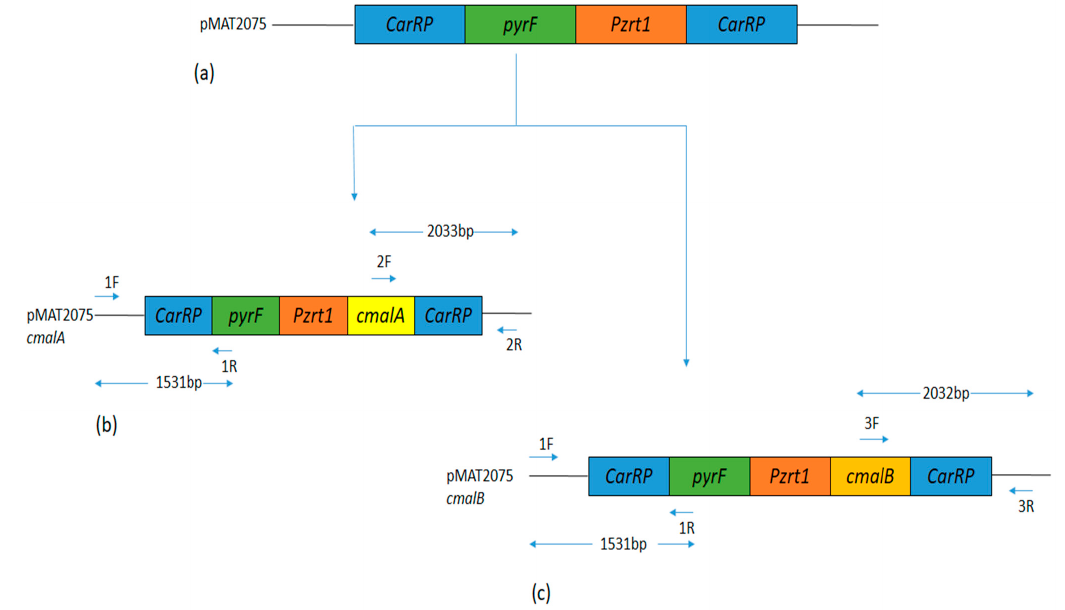
Figure 1. Overexpression of cmalA and cmalB genes. ( a ) Plasmid structure of plasmid pMAT2075. ( b ) Plasmid structure of pMAT2075- cmalA in Mc-cmalA-4 strain. Positions for primers 1F, 1R, 2F, and 2R are indicated. ( c ) Plasmid structure of pMAT2075- cmalB in Mc-cmalB-5 strain. Positions for primers 1F, 1R, 3F, and 3R are indicated.